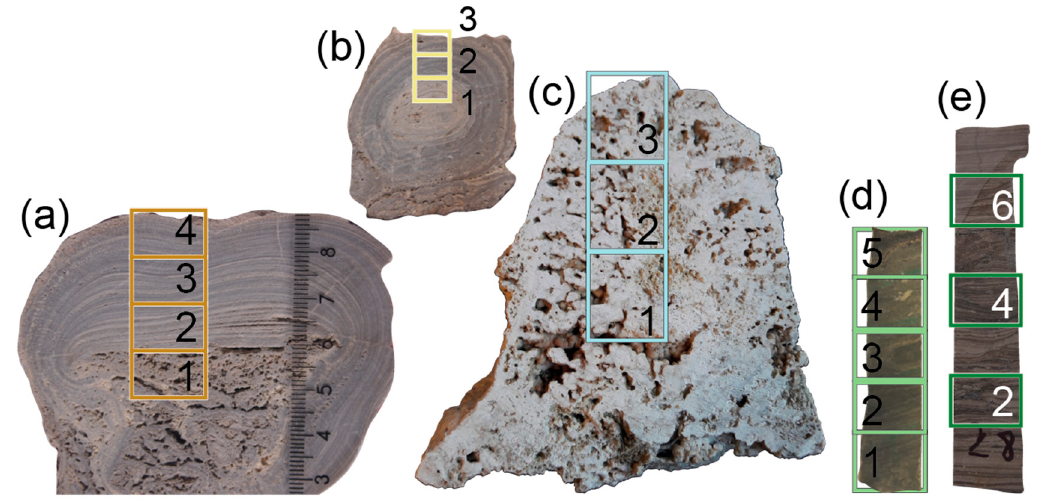
Figure 1. Photographs of microbialite samples, numbered boxes indicating sample positions (cm-scale in ( a ) applies for all samples, see also Table 1). Two specimens from Marion Lake (MRN) were investigated: ( a ) profile A, ( b ) profile B. ( c ) Mono Lake, ( d ) Andrée Land Group (ALG; bulk sample not indicated), ( e ) Bitter Springs Formation (BSF).